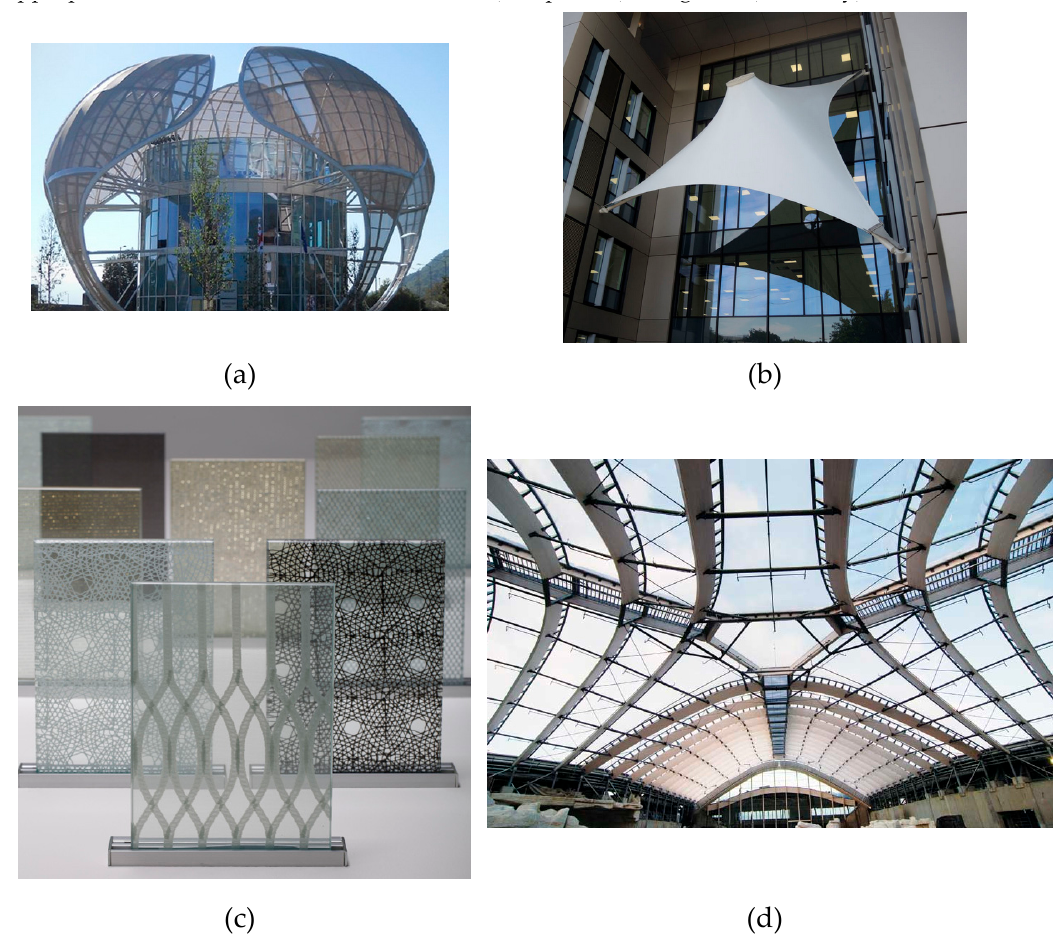
Figure 2. Selected examples of textiles in glass facades and assemblies: ( a )-( b ) textile facades with shading membranes (reproduced from [25,26]); ( c ) glass textile samples (Tex Glass® reproduced from [27]); and ( d ) textiles for enhanced acoustic comfort of glass halls (reproduced from [28]).